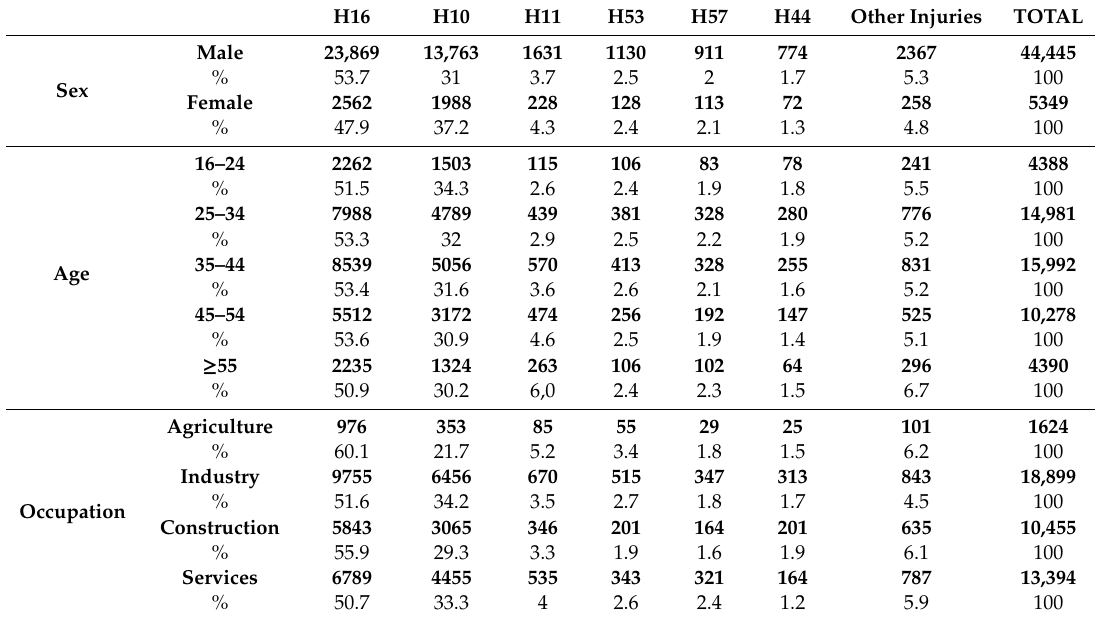
Table 3. Work-related eye injuries by sex, age, and occupation in the 7 groups of